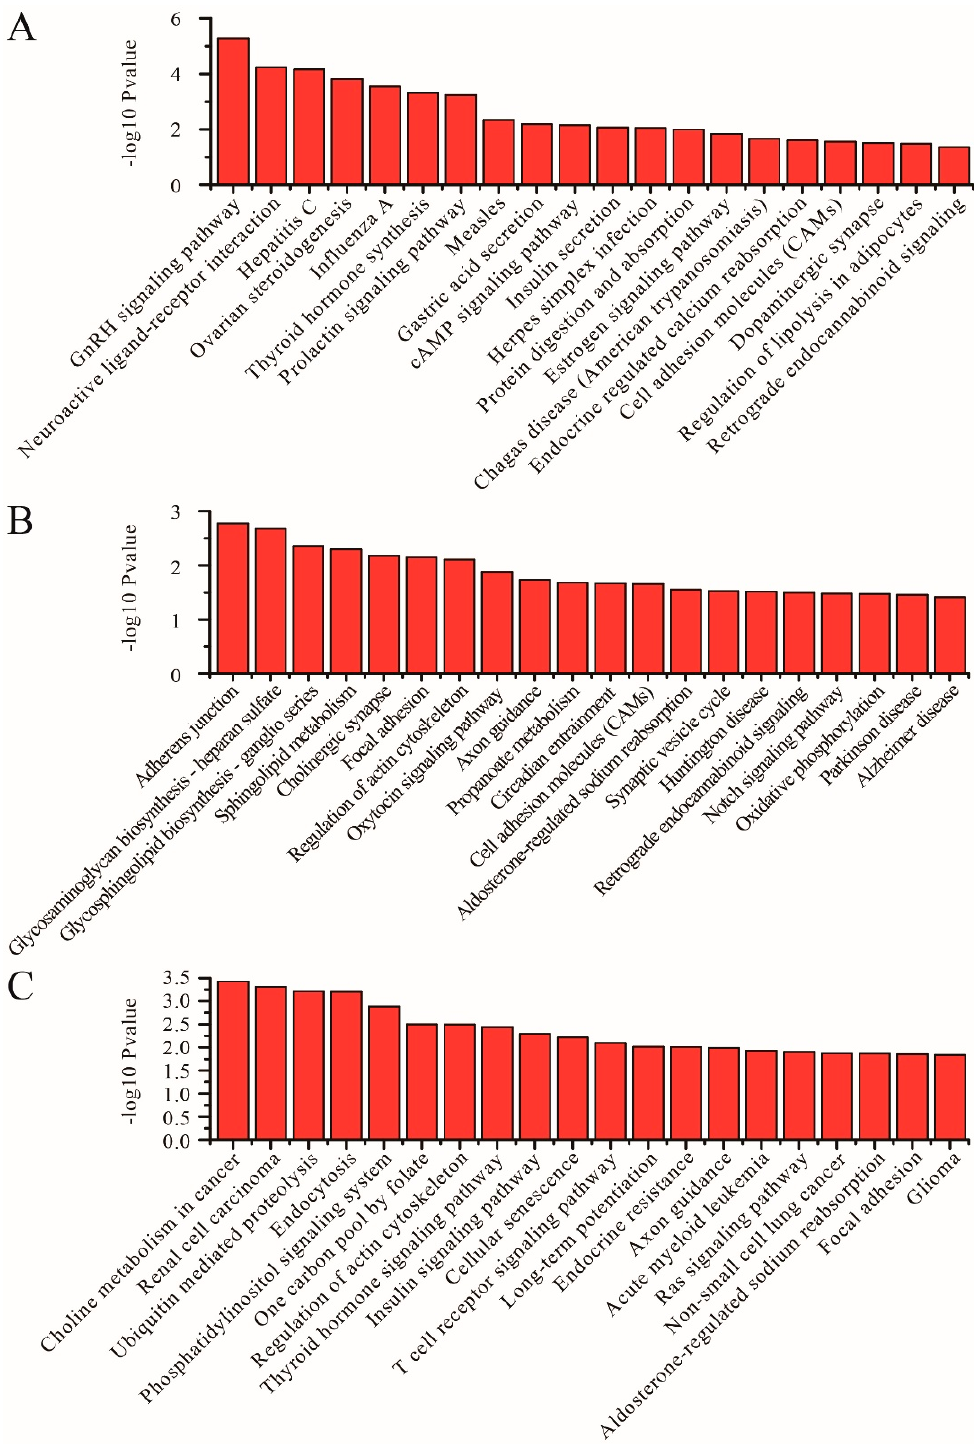
Figure 5. KEGG analyses of di ff erentially expressed genes between the LP and SLP groups. ( A ) The top 20 KEGG enrichment pathways for di ff erentially expressed mRNAs between the LP and SLP groups. ( B ) The top 20 KEGG enrichment pathways for di ff erentially expressed lncRNA target genes between the LP and SLP groups. ( C ) The top 20 KEGG enrichment pathways for di ff erentially expressed circRNA host genes between the LP and SLP